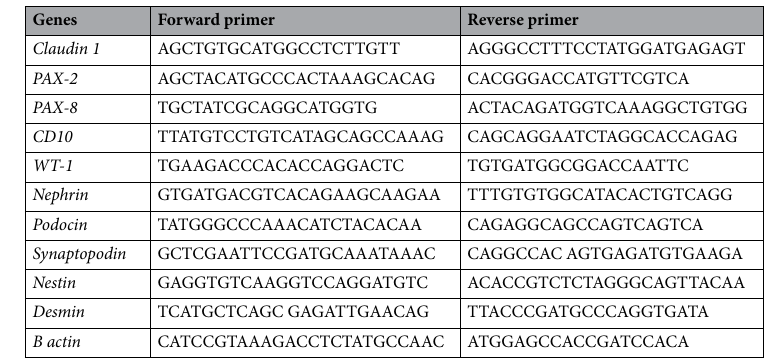
Table 2. List of primer sequences used for the RT-PCR analysis in this